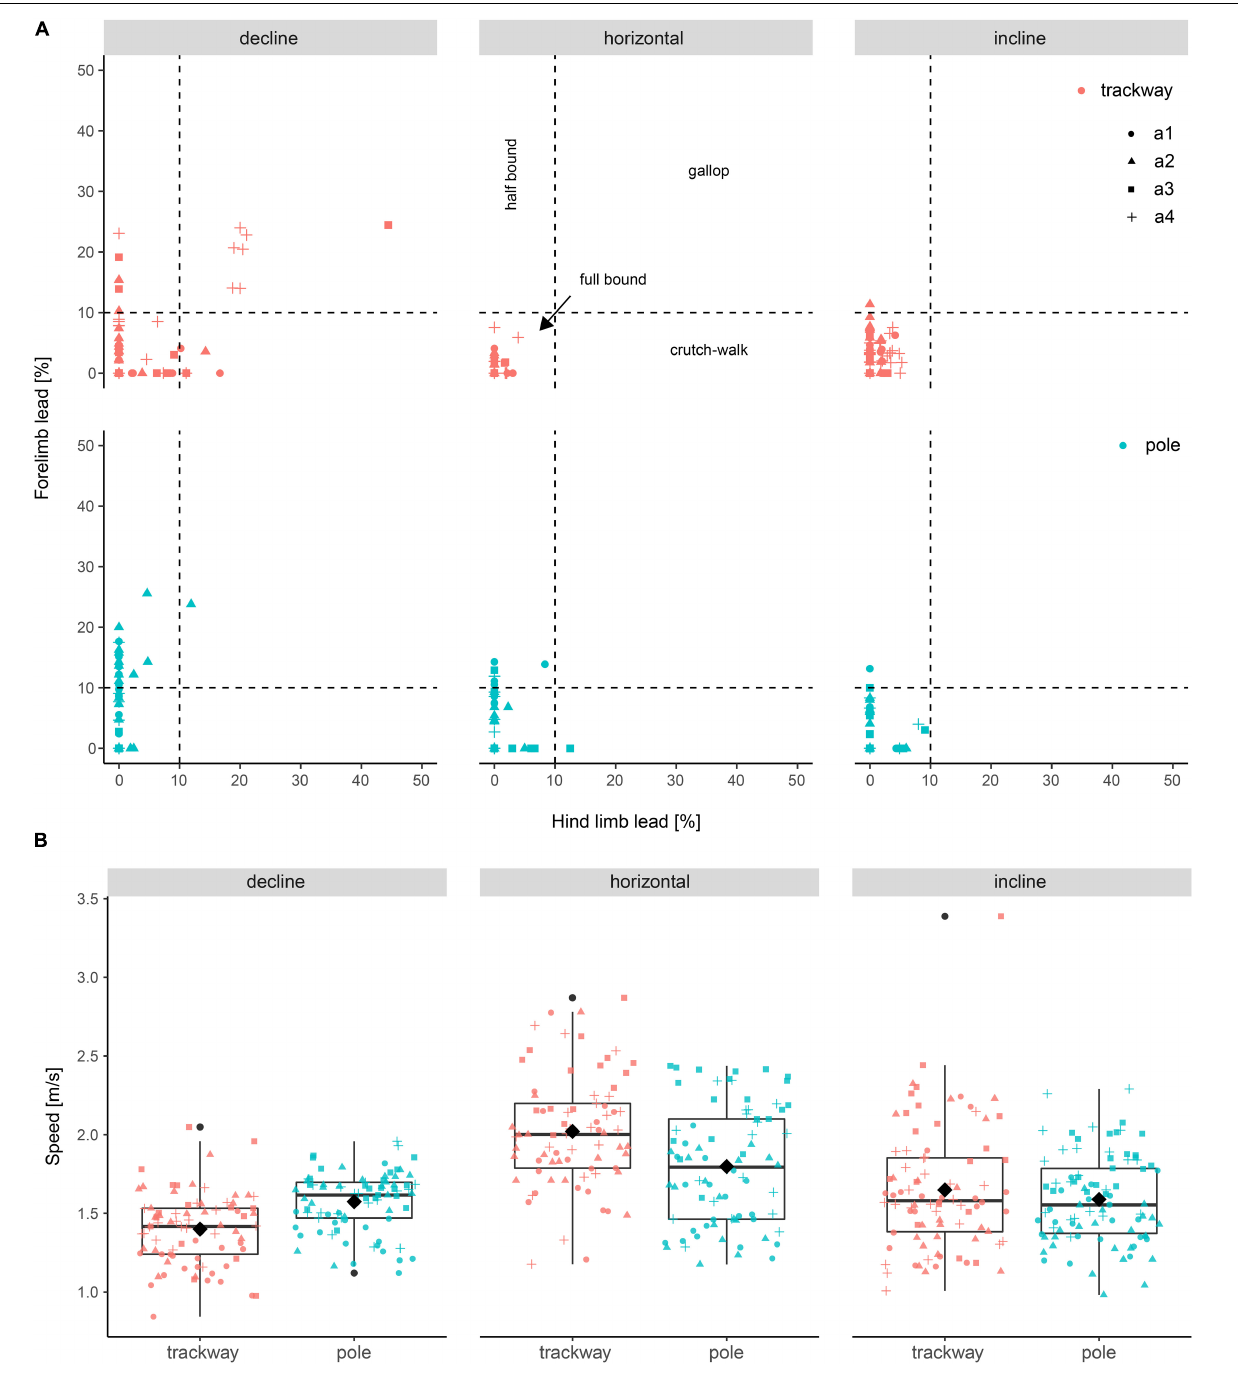
DF-HL was significantly larger at low and medium speeds ( p - always < 0.001) but not at a high speed ( p = 0.731). On the pole, the animals displayed a similar DF-FL pattern, with it